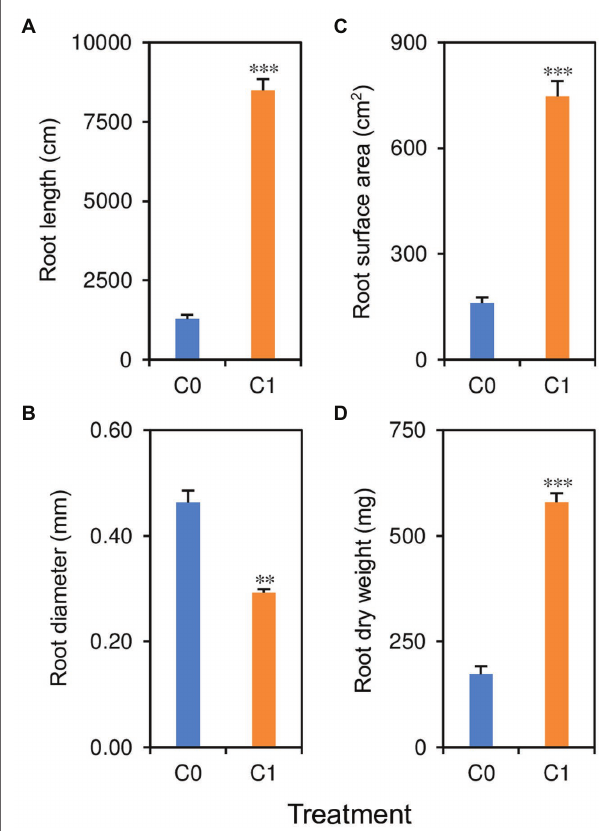
FIGURE 3 | (A) Root length, (B) root diameter, (C) root surface area, and (D) root dry weight in rice plants grown with (C1) and without (C0) biochar application. ** and *** indicate that the means of the rice plants in C1 treatment are significantly different from those in the C0 treatment at the 0.01 and 0.001 levels,